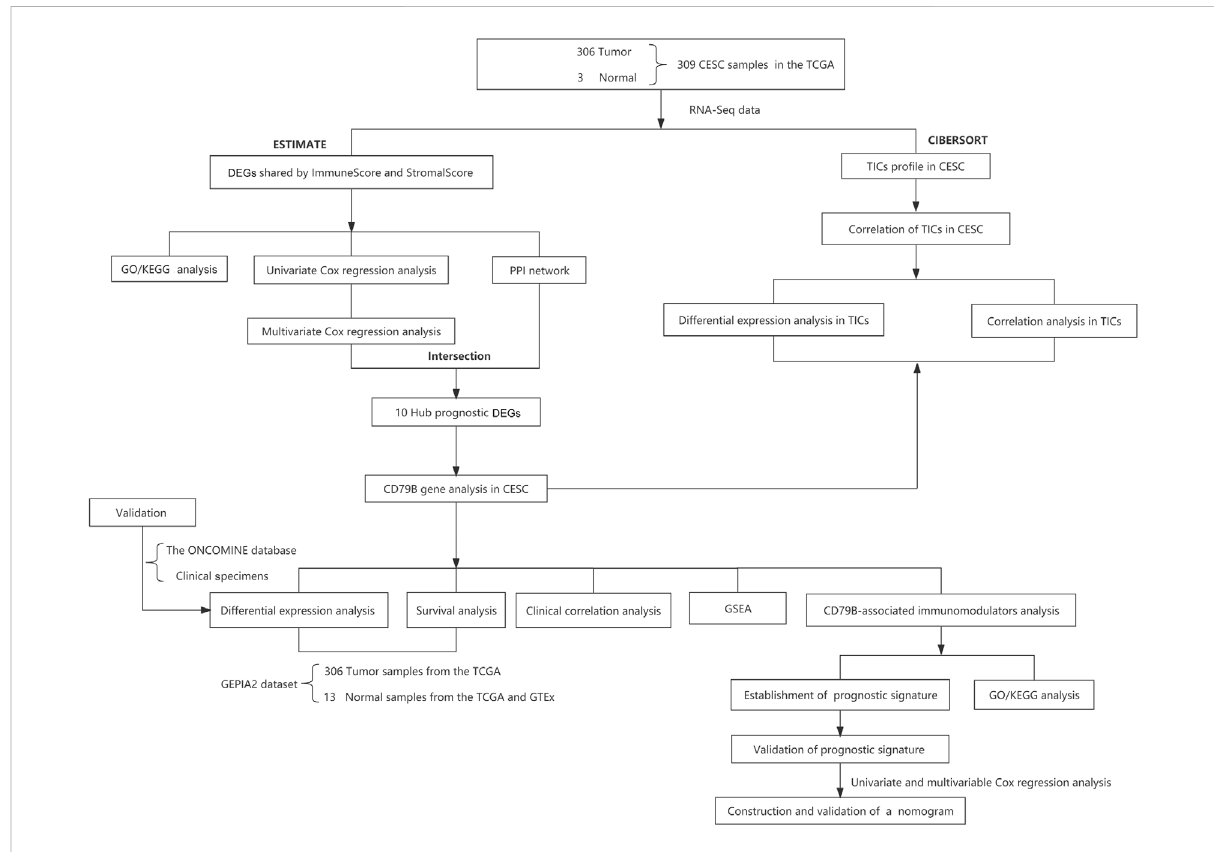
FIGURE 1 Study design and work fl